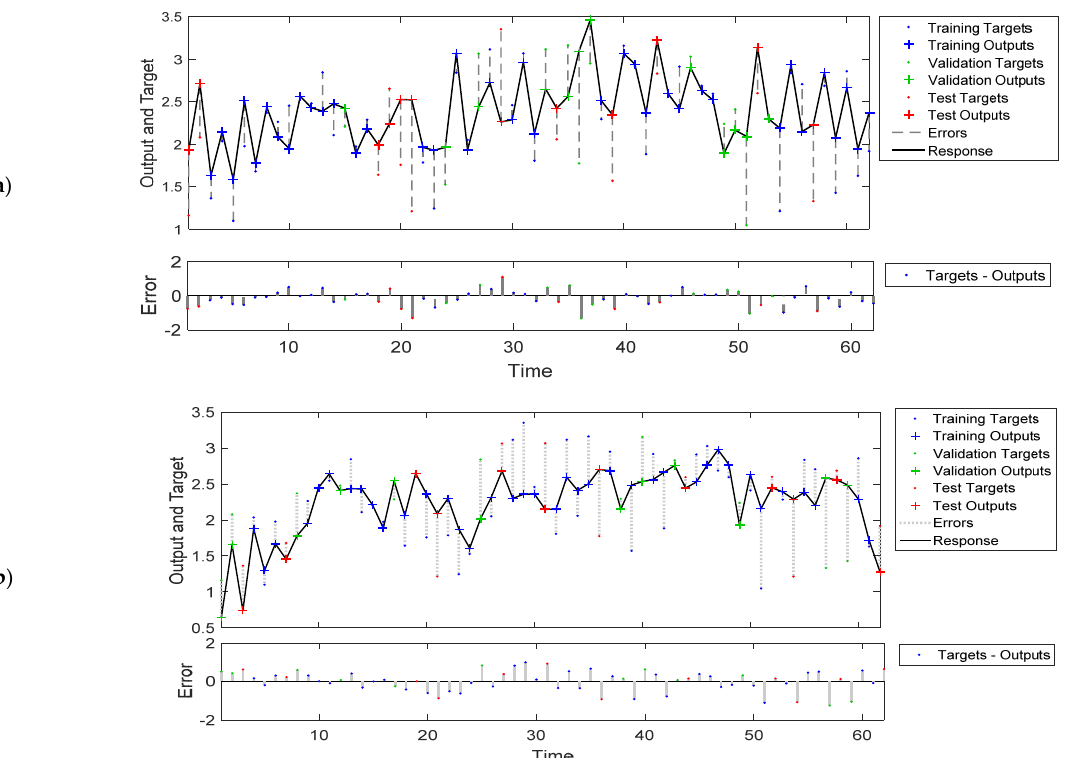
Figure 4. NARX ( a ) and FTD ( b ) neural network training, validation, and testing performance. Note that the best validation performance for the NARX model was 0.388 at epoch 3, and for the FDR model, it was 0.276 at epoch 3.